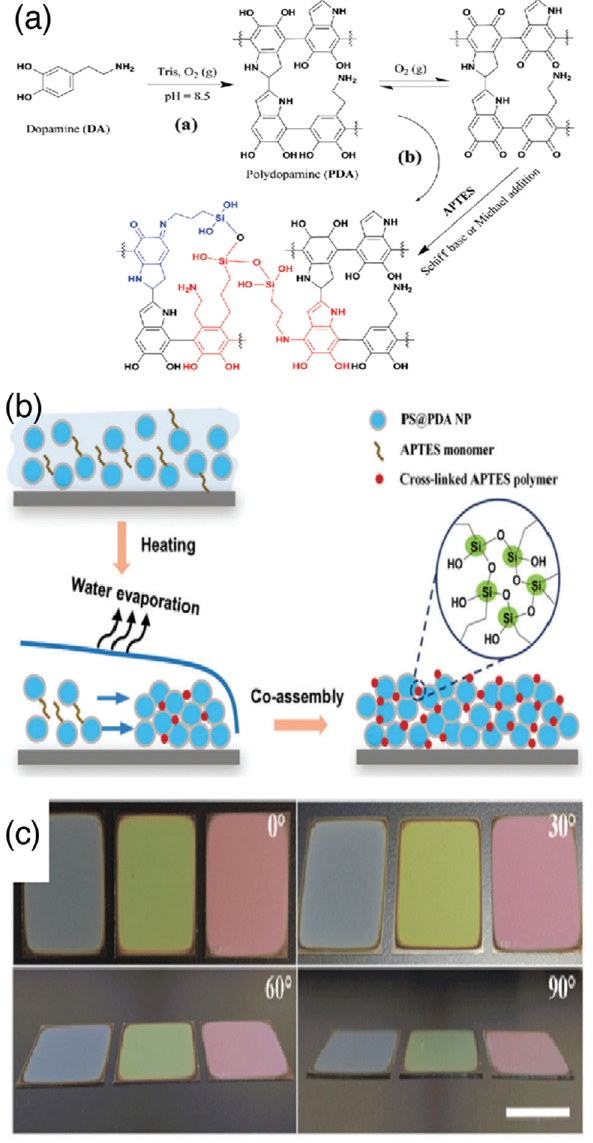
Figure 5: (( a ) ( a ) the polymerization of dopamine and ( b ) the reac - tion mechanism of dopamine and APTES ) . ( b ) Schematic diagram of the preparation of crack - free amorphous PCs and the crack elimi - nation mechanism. ( c ) The photos of PS@PDA/APTES hybrid PC fi lm were observed from di ff erent perspectives under ambient light; PS core diameters were 162 nm ( blue ) , 186 nm ( green ) and 252 nm ( red ) , respectively. The mass ratio of APTES to PS@PDA NPs was 1:5 [ 115 ]